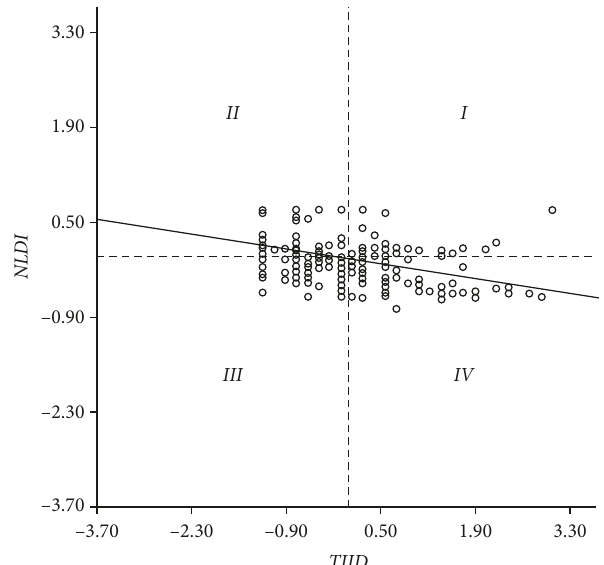
Figure 14: Scatter diagram of global spatial autocorrelation between TIID and NLDI